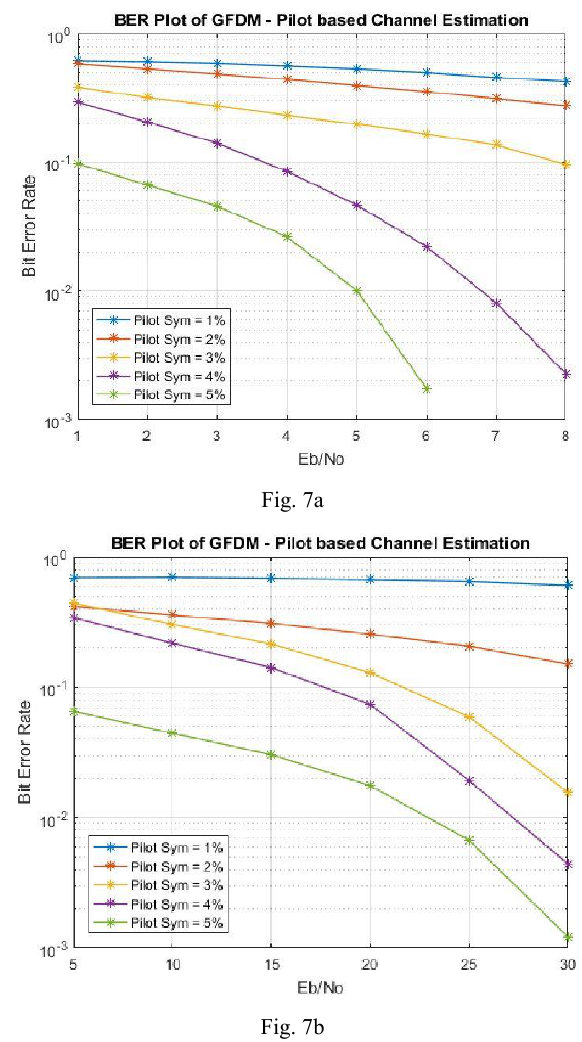
Fig. 7. BER plot when Pilot Symbols are clustered in the center of the data. (Method